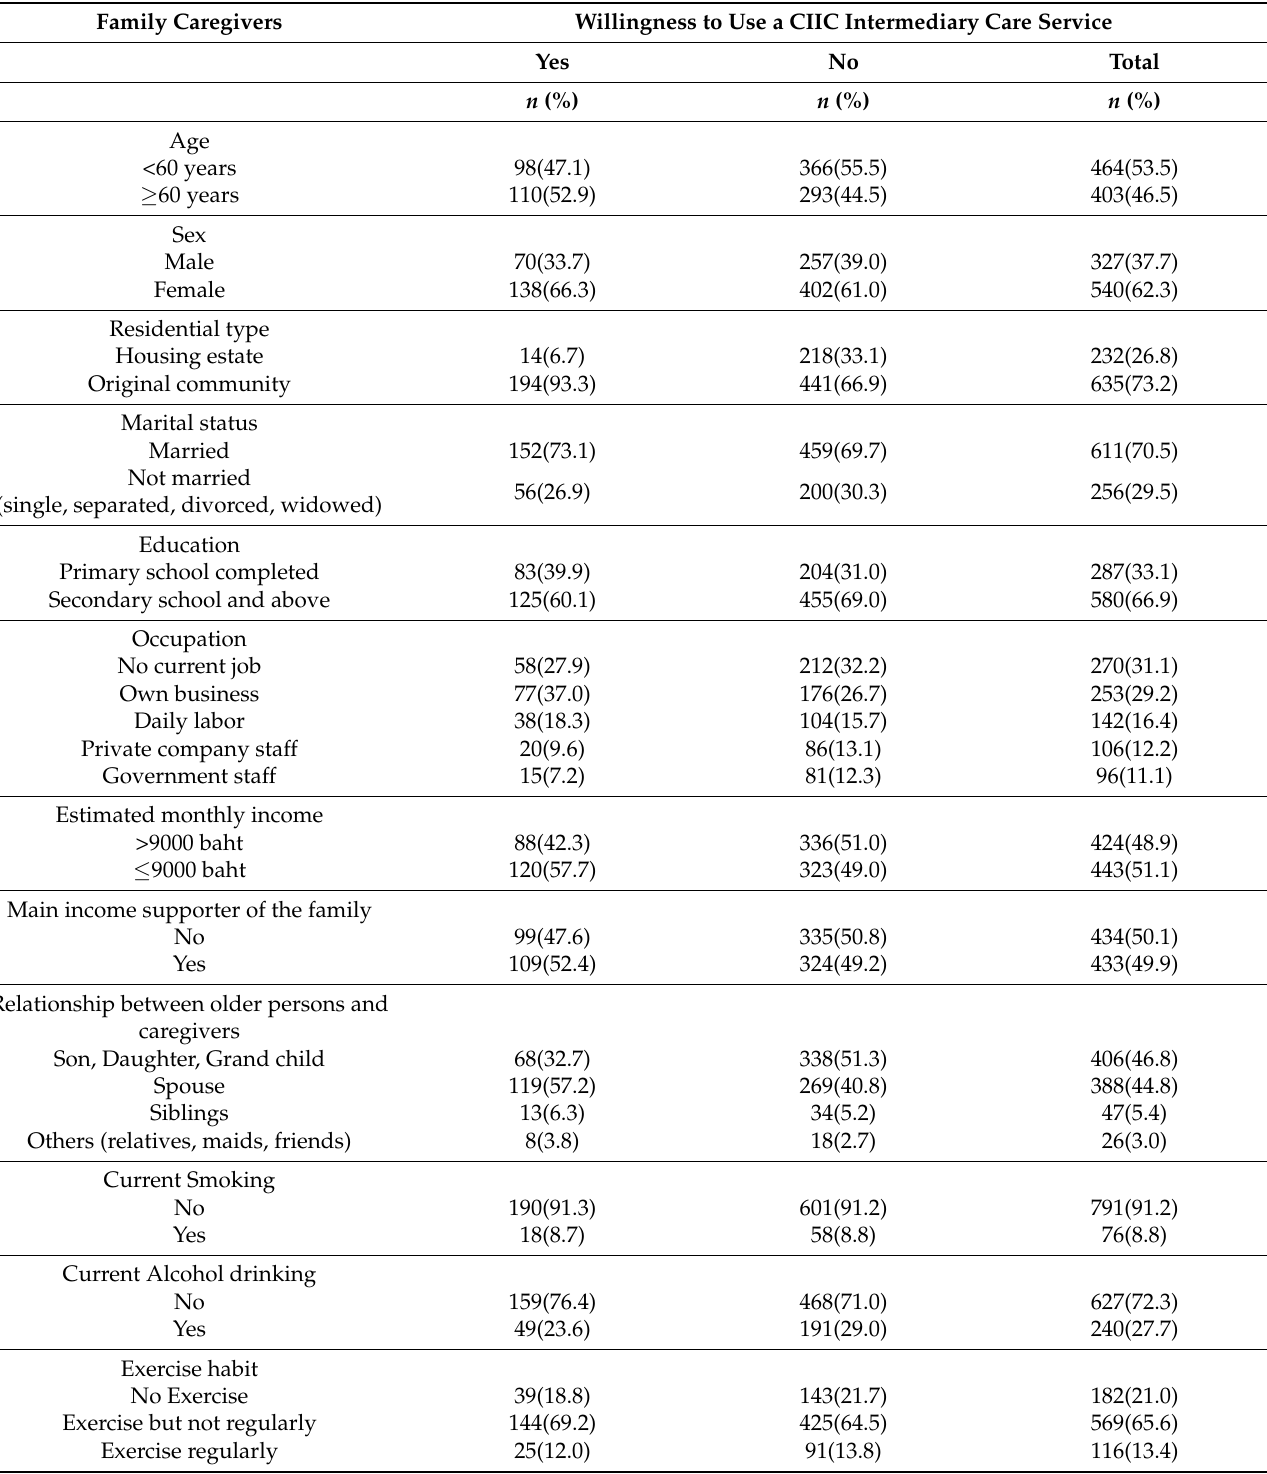
Table 1. Characteristics of the family caregivers, Maehia subdistrict, Chiang Mai, Thailand 2019 ( n = 867). Family